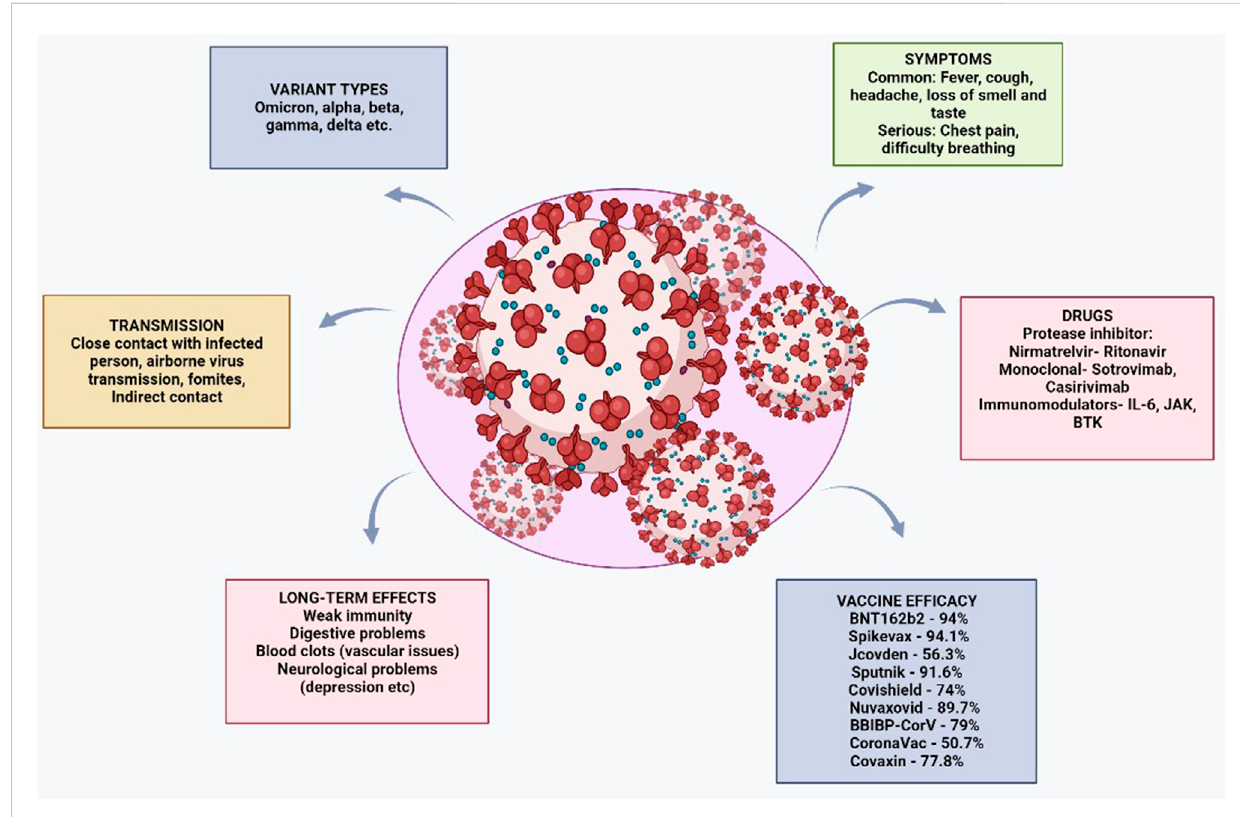
Comprehensive overview of the coronavirus, including relevant risk factors and drugs used for its